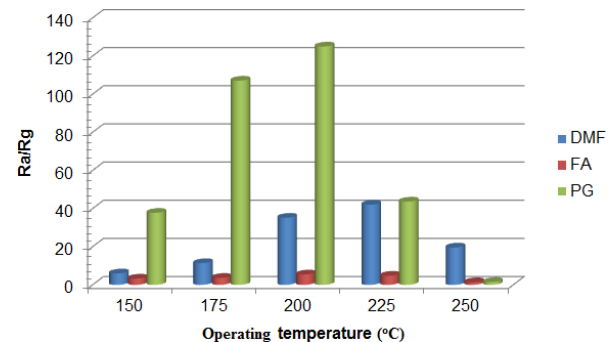
Figure 16. Comparison of responses of MWCNTs/SnO 2 sensors to 650ppm PG, 500ppm DMF and 1160ppm FA vapor exposure at various operating